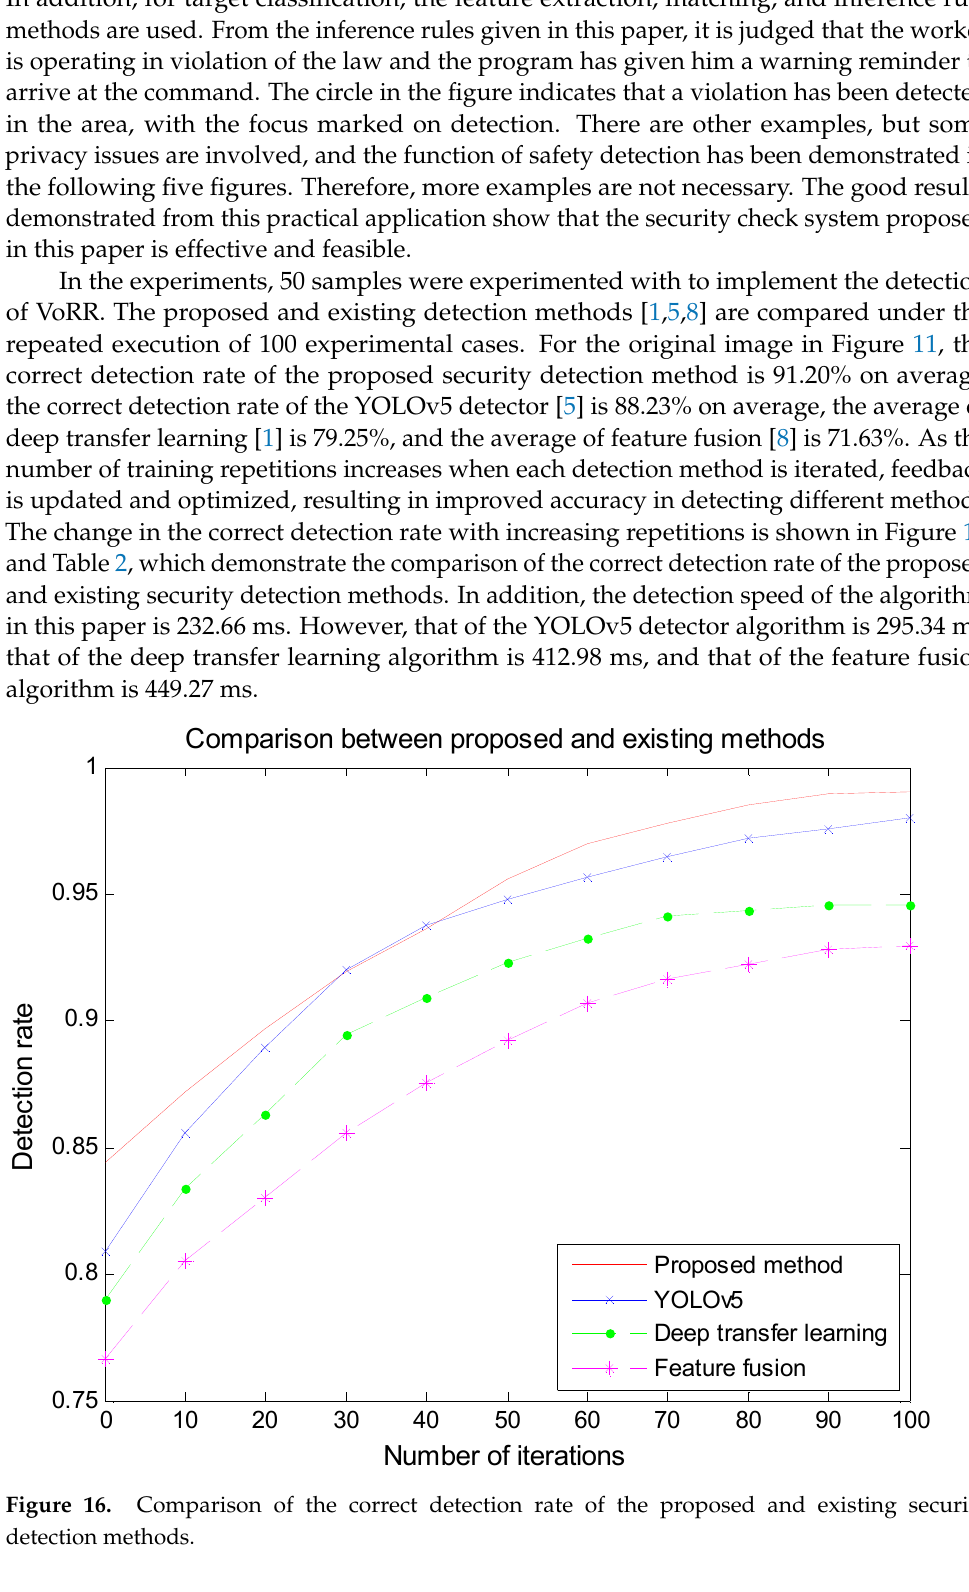
Figure 16. Comparison of the correct detection rate of the proposed and existing security detection methods. Table 2. Comprehensive comparison of proposed and existing security detection methods.